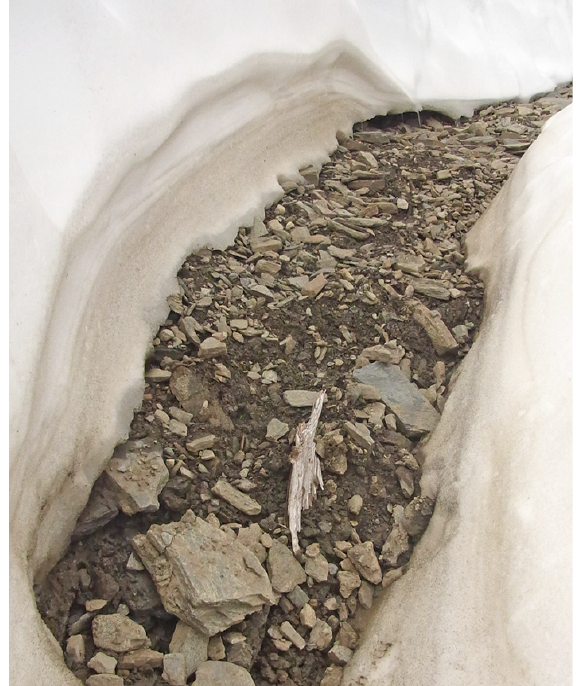
Figure 40: Slåttatjåkka (9). Pine wood remnant appearing in a “channel” opened in the snow/ice